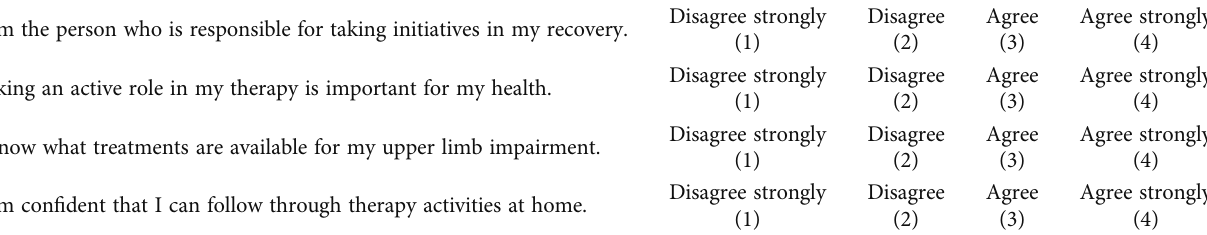
Table 3: Self-e ffi cacy